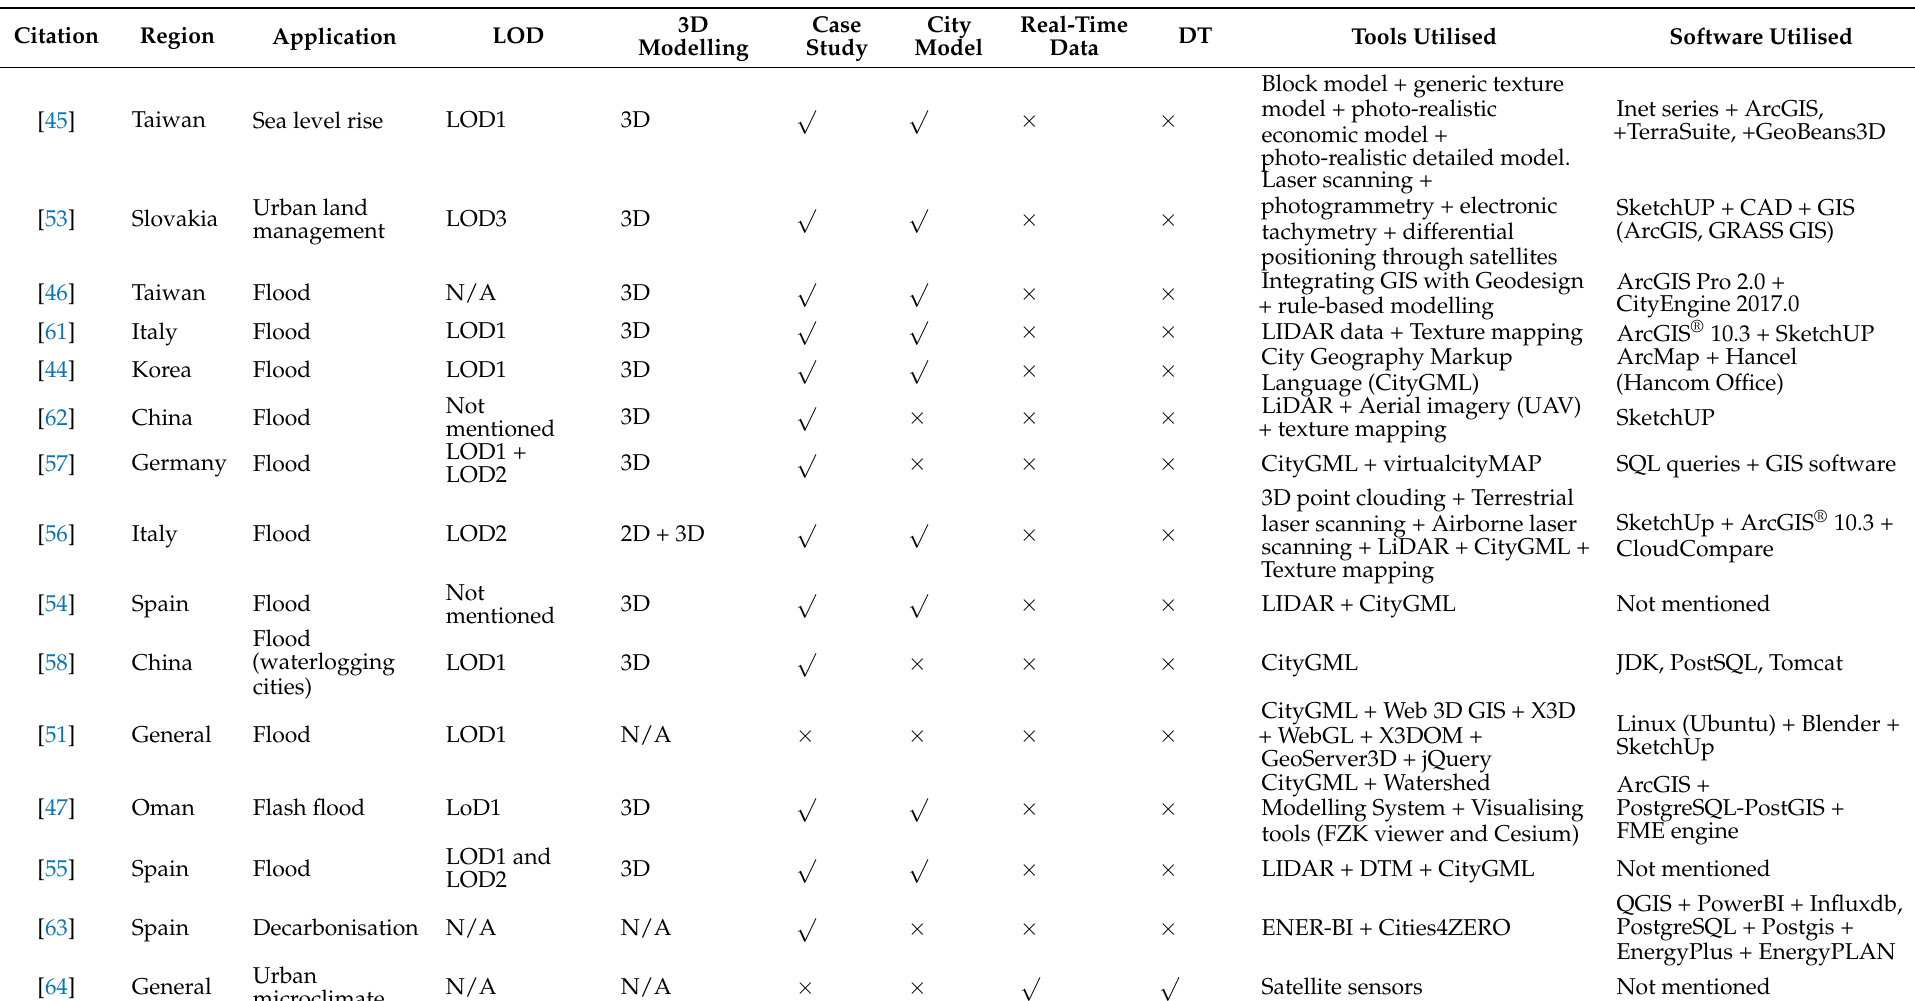
Table 2. List of eligible virtual 3D city model articles included in the review with their research objectives and other